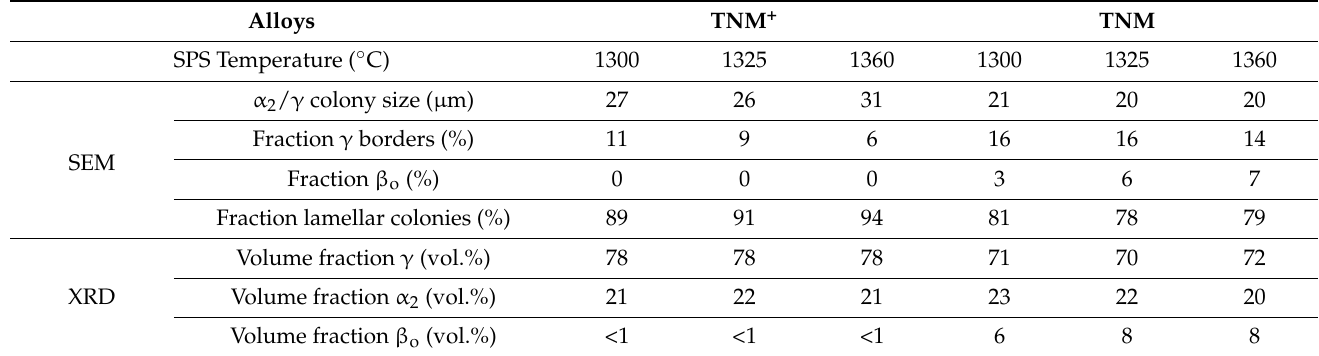
Table 2. Quantitative characterization of the SPS materials by SEM image analysis and XRD. The accuracy of the values determined are within ± 5 µ m for the colony size, ± 5% for the surface fraction by SEM and ± 1% for the volume fraction by